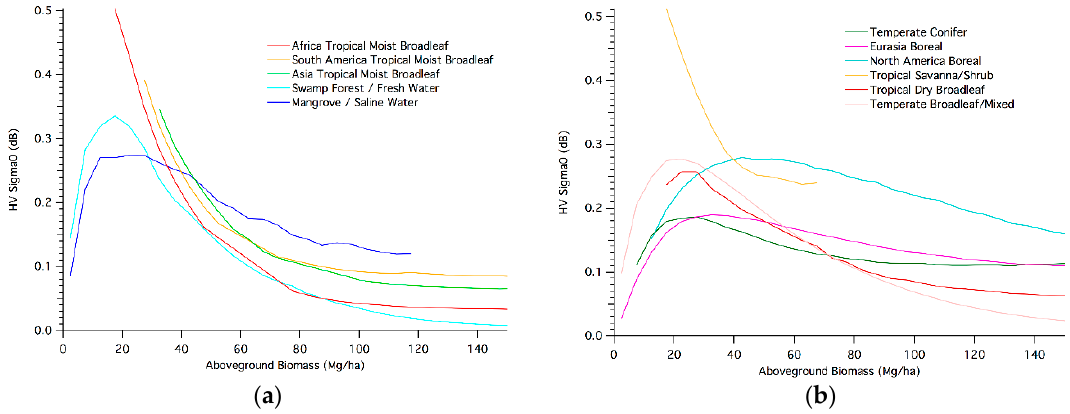
Figure 4. Radar sensitivity required to detect a 20% change in AGB. The sensitivity requirement is calculated using Equations (3) and (4). The values for each bin are calculated using the derivatives from Equations (3) and (4) at the middle AGB value for each bin and ±10% from that middle AGB value. A total of 10 forest types are distinguished here, for better visibility, they are plotted in two separate figures: ( a ) Africa tropical moist broadleaf, South America tropical moist broadleaf, Asia tropical moist broadleaf, swamp forest/fresh water, mangrove/saline water ( b ) temperate conifer, Eurasia boreal, North America boreal, tropical savanna/shrub, and tropical dry broadleaf.